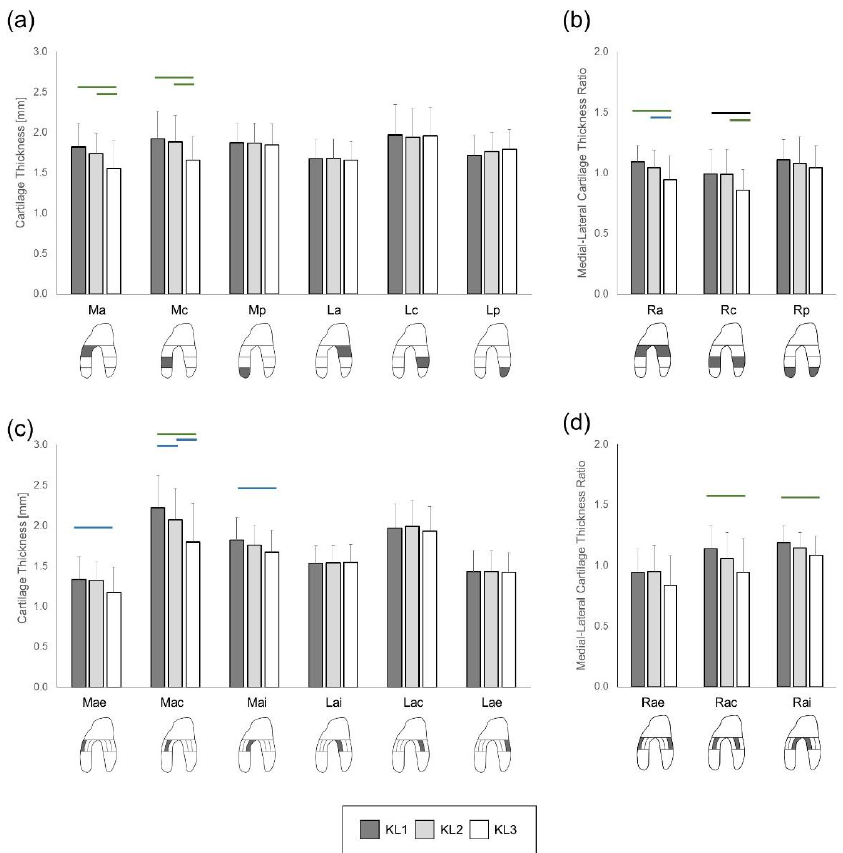
Figure 4. Bar plots (mean ± standard deviation) of cartilage thickness per VOI ( a ) and sub-VOI ( c ) and their respective medial-lateral ratios ( b and d ). Horizontal bars indicate statistically significant ( p < 0.017) changes between severity timepoints (blue: ES > 0.5; green: ES > 0.8; black: ES > 1.2).